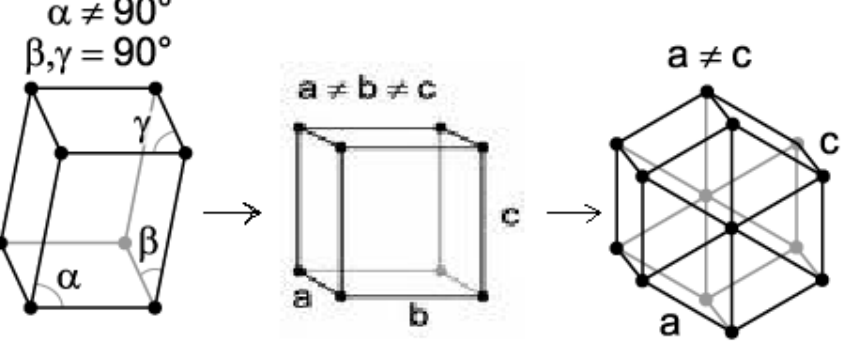
Figure 1. Scheme for Solid-State Phase Transitions Exhibited by n-Paraffin Specimens of This Study (Monoclinic to Orthorhombic followed by Orthorhombic to Hexagonal Crystal Forms).